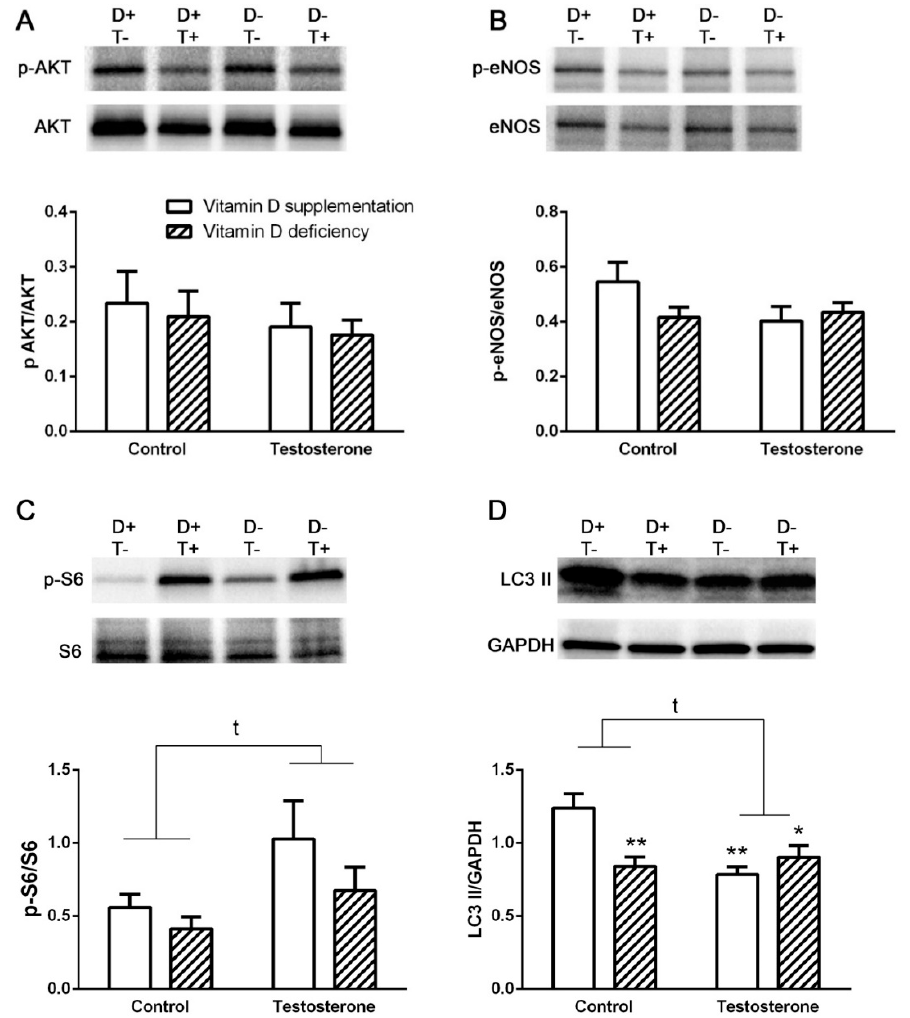
Figure 2. Alterations in insulin signaling pathway and autophagy in the liver. ( A ) Akt phosphorylation in liver tissue. ( B ) eNOS phosphorylation in liver tissue. ( C ) Protein S6 phosphorylation in the liver. ( D ) LC3 II formation in the liver. LC3 II levels normalized to GAPDH. Data are presented as mean ± SEM. Two-way (factor 1—vitamin D supplementation vs. vitamin D deficiency; factor 2—control vs. testosterone treatment) ANOVA; t: p < 0.05 control vs. testosterone treatment; Tukey’s post hoc test (comparison of experimental groups), * p < 0.05 vs. D+T– group, ** p < 0.01 vs. D+T– group; n = 5–8 in each group.